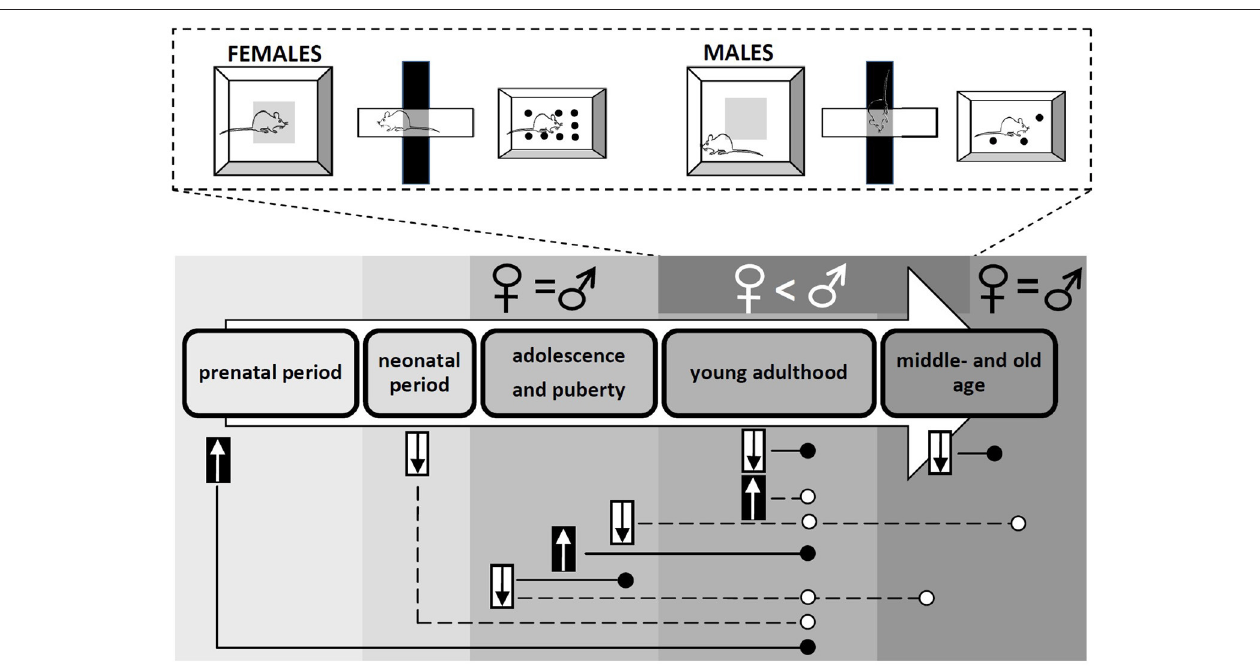
FIGURE 1 | Sex differences in anxiety-like behavior assessed using the open field, elevated plus maze and marble-burying tests. The consequences of testosterone exposure and deprivation in males are shown across the life. - testosterone exposure; - testosterone deprivation; ◦ - anxiolytic effect; (cid:8) - anxiogenic